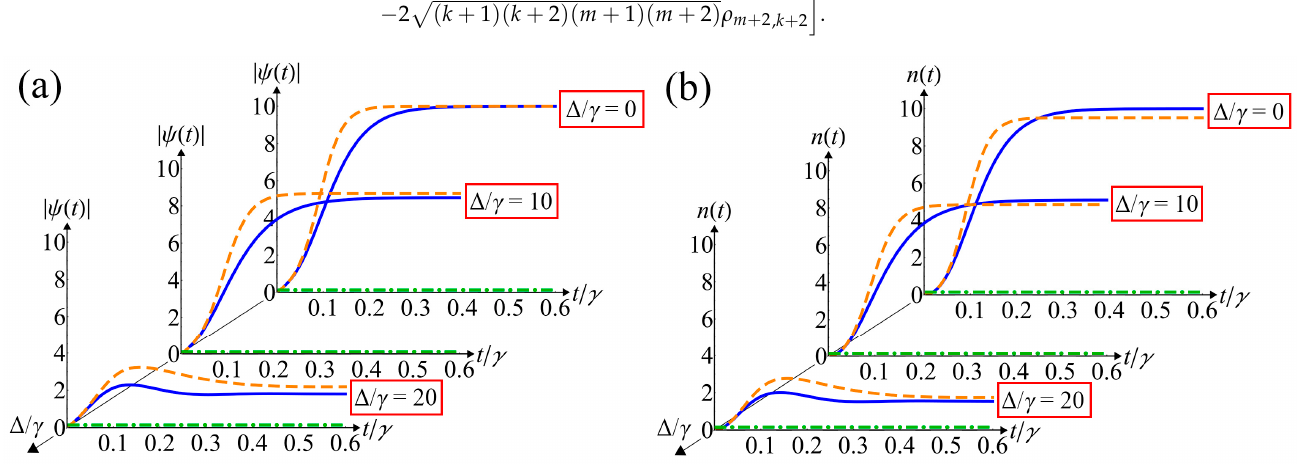
Figure 2. Time evolution of the modulus of anomalous average | ψ ( t )| ( a ) and the average number of photons n ( t ) ( b ) for different values of the frequency detuning ∆ . It is obtained from numerical simulation of the Lindblad master equation on a truncated Fock basis (blue curve), numerical integration of the mean-field Equations (12) and (13) (orange dashed curve) and the semiclassical solution (green dash-dotted line). The normalized two-photon pump rate is set to g / γ = 20.